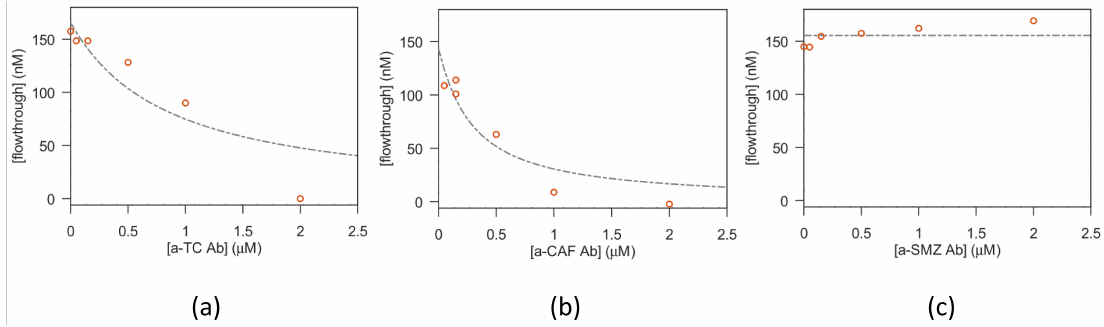
Figure 8. Characterization of binding between TC/CAF/SMZ and their Abs in solution (filtration